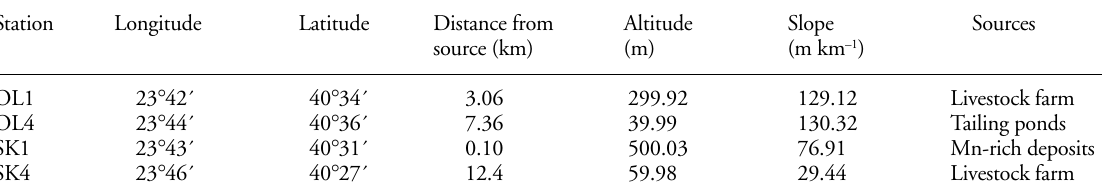
Table 1. Physical characteristics and sources of pollution of the sampling stations of Kipouristras stream at Olympias area (OL1and OL4) and Piavitsa (SK1) – Asprolakka (SK4) streams at Skouries area. Station